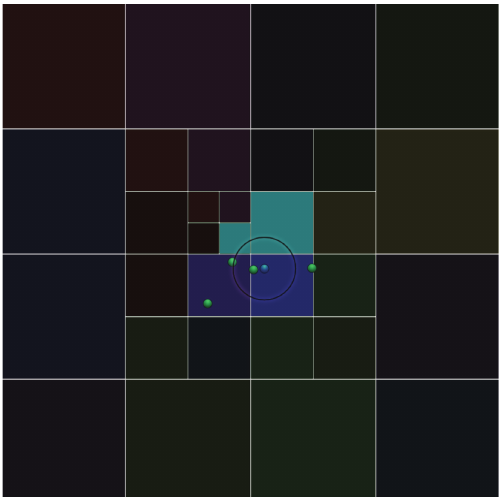
Figure 4: A client with reduced AOI in a more intricately subdivided virtual world (distributed over several logic